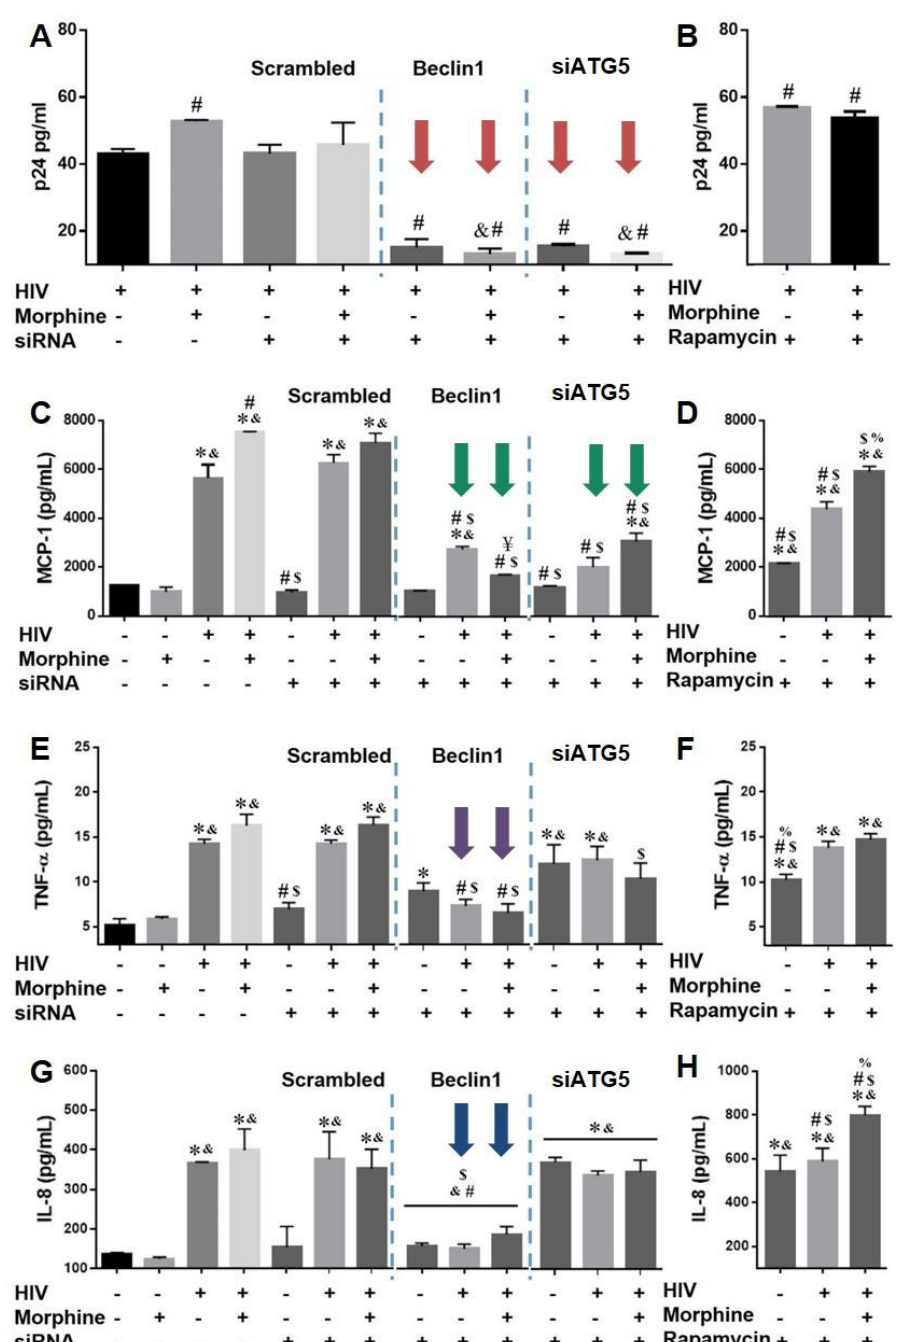
Figure 3. HIV replication and induced inflammation are mediated by the autophagy pathway. ( A , B ) HIV replication in human astrocytes infected with HIV alone or in combination with morphine (1 µM) was measured using HIV p24 Gag protein ELISA. Values were determined from standard curves and are presented as the mean ± SEM of three independent experiments ( p < 0.05 # vs. HIV, & vs. HIV + MOR). ( D – H ) Corresponding cell culture supernatants were also used to detect the levels of pro-inflammatory cytokines ( C , D ) monocyte chemotactic protein-1 (MCP-1), ( E , F ) tumor necrosis factor alpha (TNF- α ) ( G , H ) and interleukin (IL)-8 by ELISA. Values were determined from standard curves and are presented as the mean ± the SEM of three independent experiments ( p < 0.05 * vs. Control, & vs. MOR, # vs. HIV, $ vs. HIV + MOR, % vs. HIV + RAP, ¥ vs. HIV + siBeclin1).